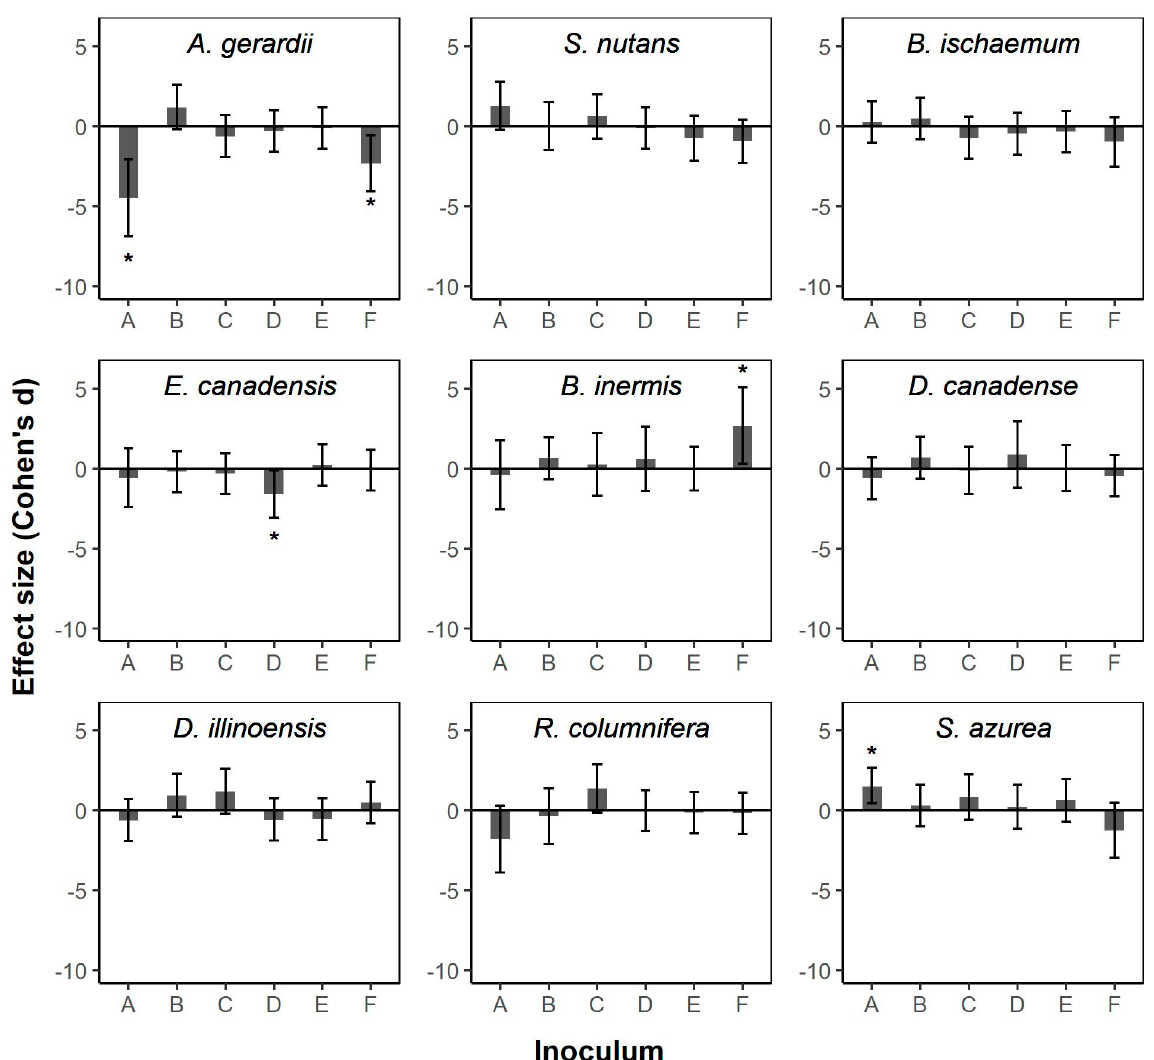
Figure 1. Effect sizes (Cohen’s d) of commercial arbuscular mycorrhizal (AM) fungal inoculants on total biomass productions of nine plant species commonly found in central North American grass- lands ( Andropogon gerardii ; Sorghastrum nutans ; Bothriochloa ischaemum (invasive); Elymus canadensis ; Bromus inermis (invasive); Desmodium canadense ; Desmanthus illinoensis ; Ratibida columnifera ; Salvia azurea ). Descriptions of inoculums A–F are given in Table 2. Error bars represent 95% confidence intervals. Asterisks indicate significant effect sizes, as determined when confidence intervals did not overlap zero.